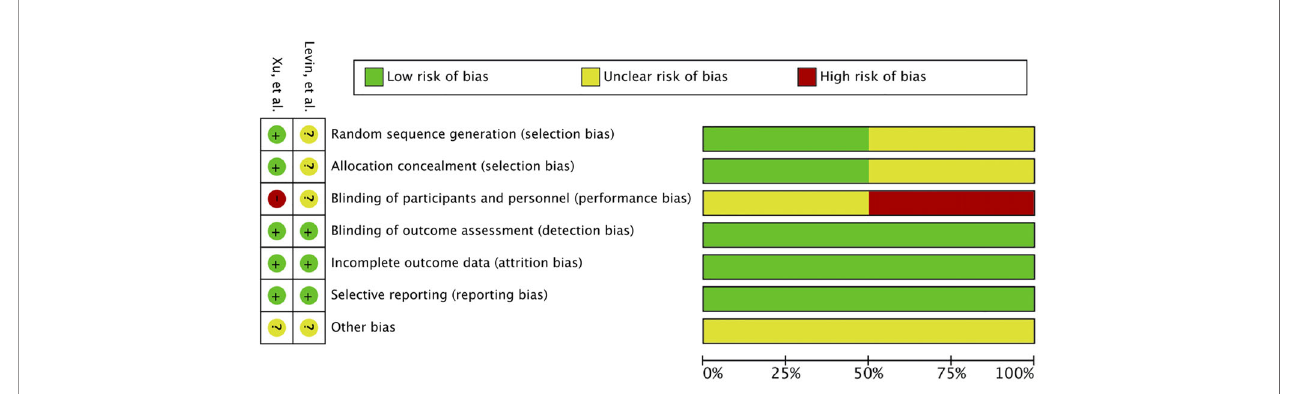
FIGURE 2 | Risk of bias assessment of two randomized controlled trials.